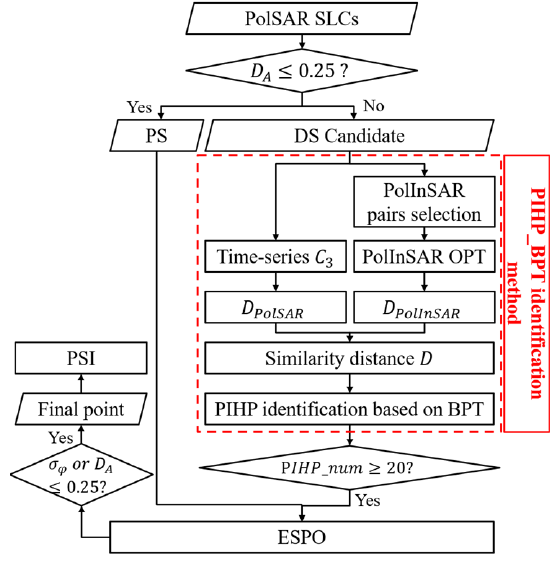
8 of 22 Figure 2. The branch pruning diagrams with pruning factor 𝑃 (cid:3404) 4 . ( left ) The hierarchical structure of branch pruning. ( right ) the 3-D branch pruning process. The letters represent the indexes of the objects, and the numbers represent the iteration numbers of each node. As shown in Figure 2, the pruned branches are indicated by dotted lines, and the remained branches are indicated by solid lines. The example marked by the red lines is explained in detail. Assuming that the method starts from leaf node 𝒃 and the pruning factor is 4, by searching upward along the red lines, the retained node 𝒍 is the last node with 𝐼𝑡𝑒𝑟 (cid:3409) 4 , and the rest nodes 𝒏, 𝒑 are considered as the pruning nodes, and the re- gion 𝒍 will be one of the PIHPs in the final result. Similarly, the dotted lines in Figure 2 represent the pruning branches when the factor is 4. By pruning, the whole image is finally divided into a multi-scale PIHP map, as shown in the bottom right image in Figure 2. 2.3. Improved MT-InSAR Processing Strategy It should be noted that the phase linking of the proposed MT-InSAR method is car- ried out under the criterion of multi-baseline equal scattering mechanism (ESM) [22,35] to ensure the phase triangulation [9] of the single-master interferometric phase. It means that the scatterers along all baselines are enforced as equal polarimetric signatures.